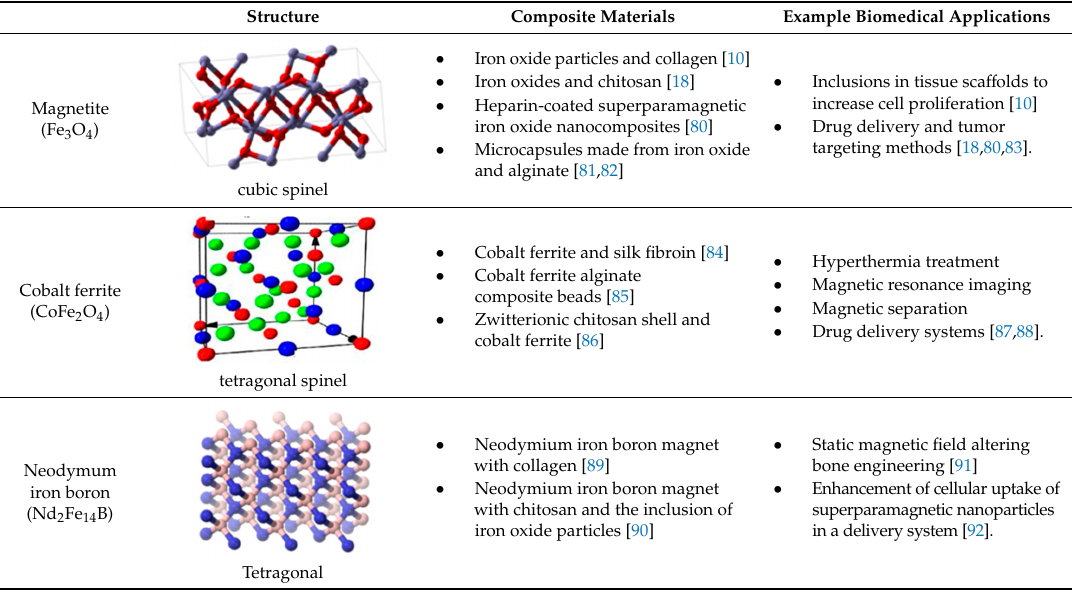
Table 1. Common medical applications of magnetic particles used today.